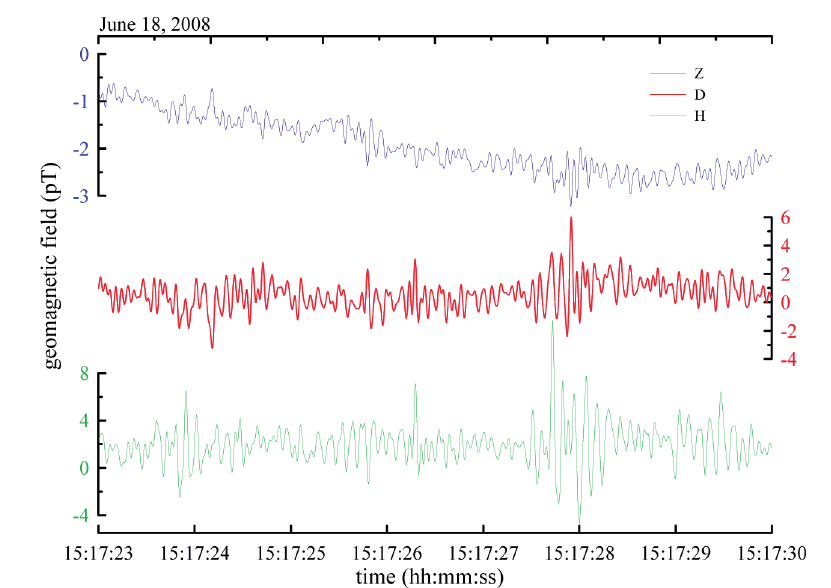
Fig. 6. An example of 7 s time domain record with a sampling rate of 256Hz. Note the presence of the SR